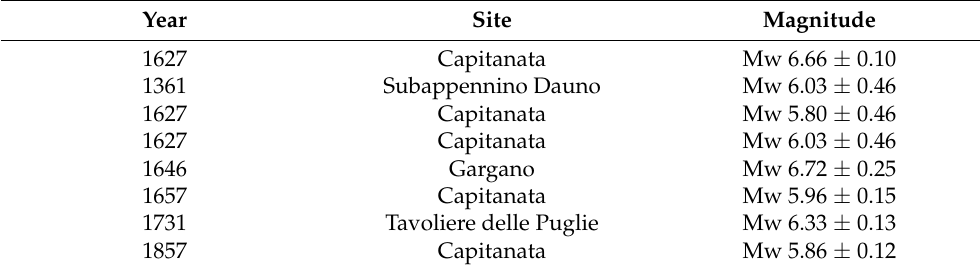
Table 1. Earthquakes with a magnitude greater than 5. Data from the historical seismic